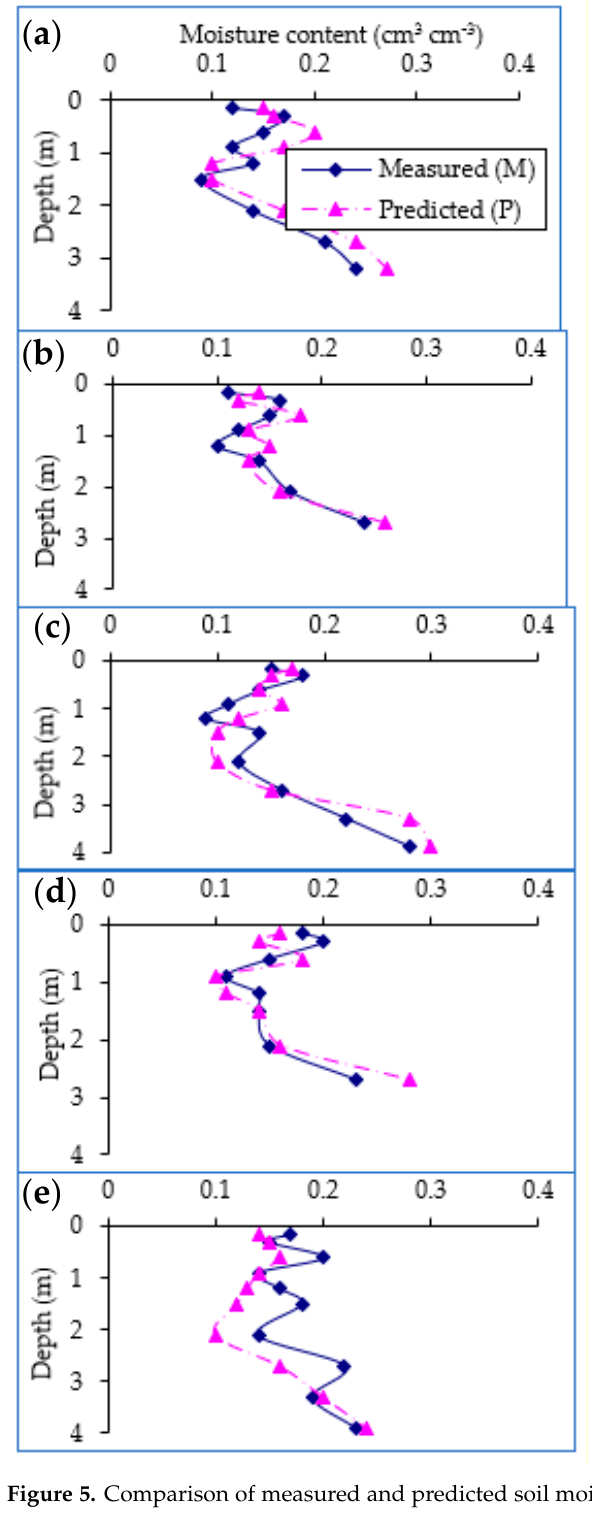
Figure 5. Comparison of measured and predicted soil moisture (cm 3 cm − 3 ) across the soil profile on 21/09/2004 of sampling site ( a ) Ghumana village ( b ) Sainsowal Khurd ( c ) Jattiwal ( d ) Jodhwal ( e ) Bhulewal.